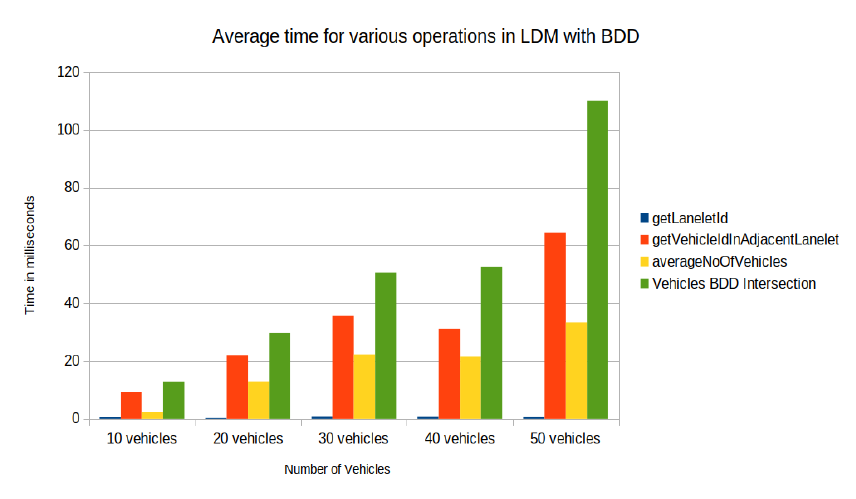
Figure 15. Time in milliseconds for operations (get ego vehicle lanelet id, get vehicles ids in adjacent lanelets of ego vehicle, average number of vehicles in adjacent lanelets, BDD intersection operation with adjacent vehicles for collision avoidance).